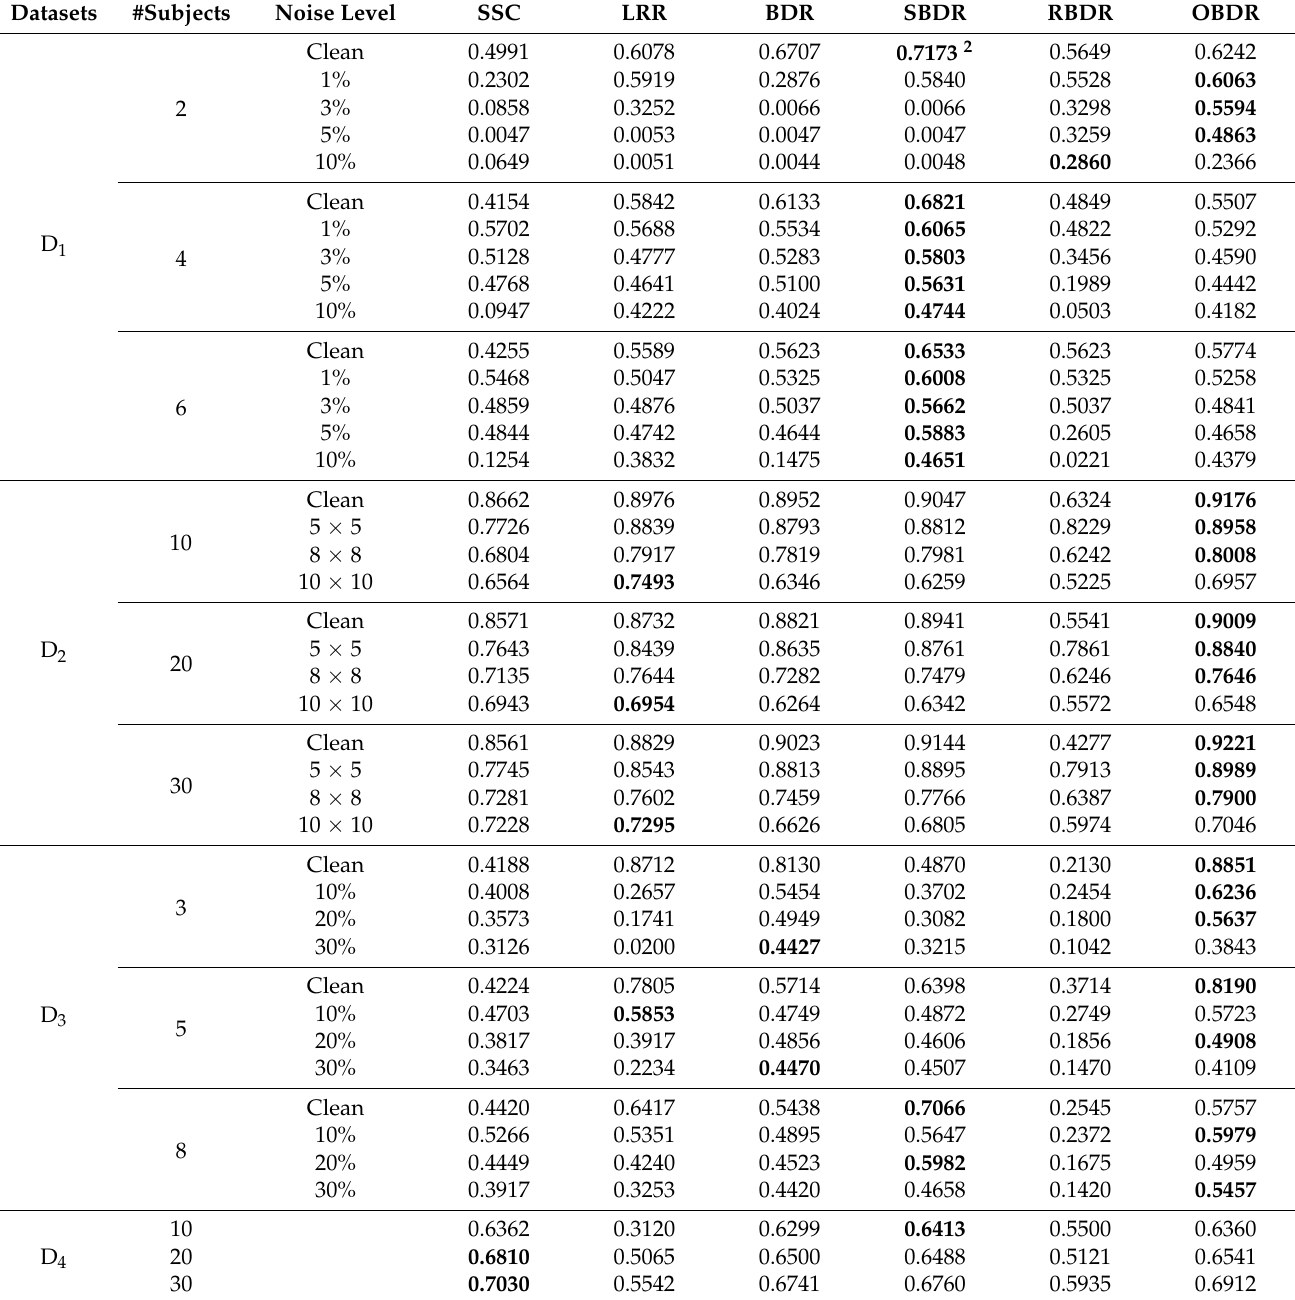
Table 4. NMIs of algorithms on